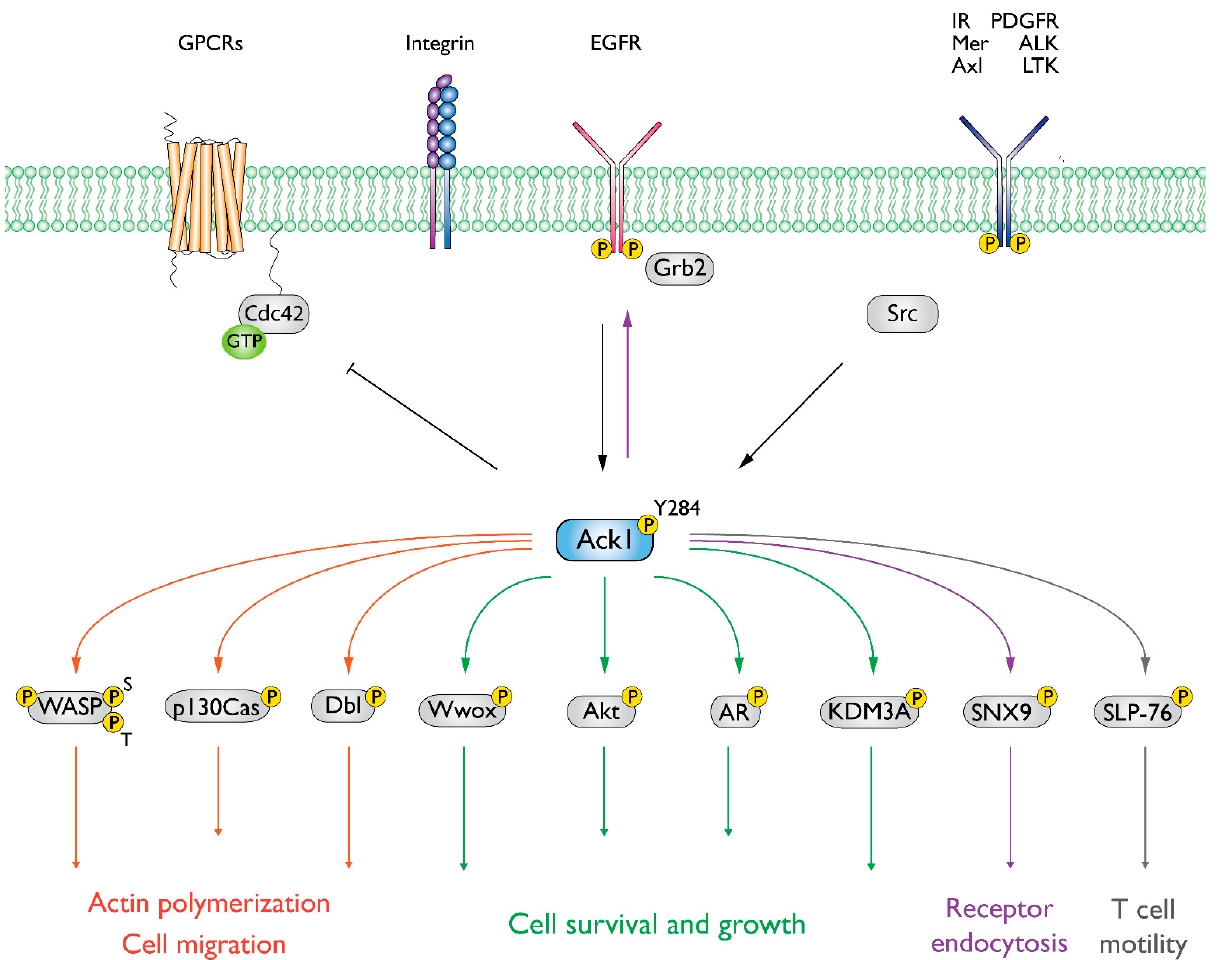
Figure 3. Summary of Ack1-mediated signaling events. Ack1 is activated in response to growth factors, G-protein coupled receptors (GPCRs), and integrin-mediated cell adhesion and is recruited to activated RTKs such as platelet-derived growth factor receptor (PDGFR), insulin receptor (IR), Mer, and epidermal growth factor receptor (EGFR) [2,3,25,28,31]. In cancer cells, Ack1 phosphorylates the tumor suppressor Wwox [3] and facilitates uncontrolled activation of pro-proliferative signals (Akt and AR). A detailed discussion of the signaling pathways can be found in the study by Fox et al. [7].